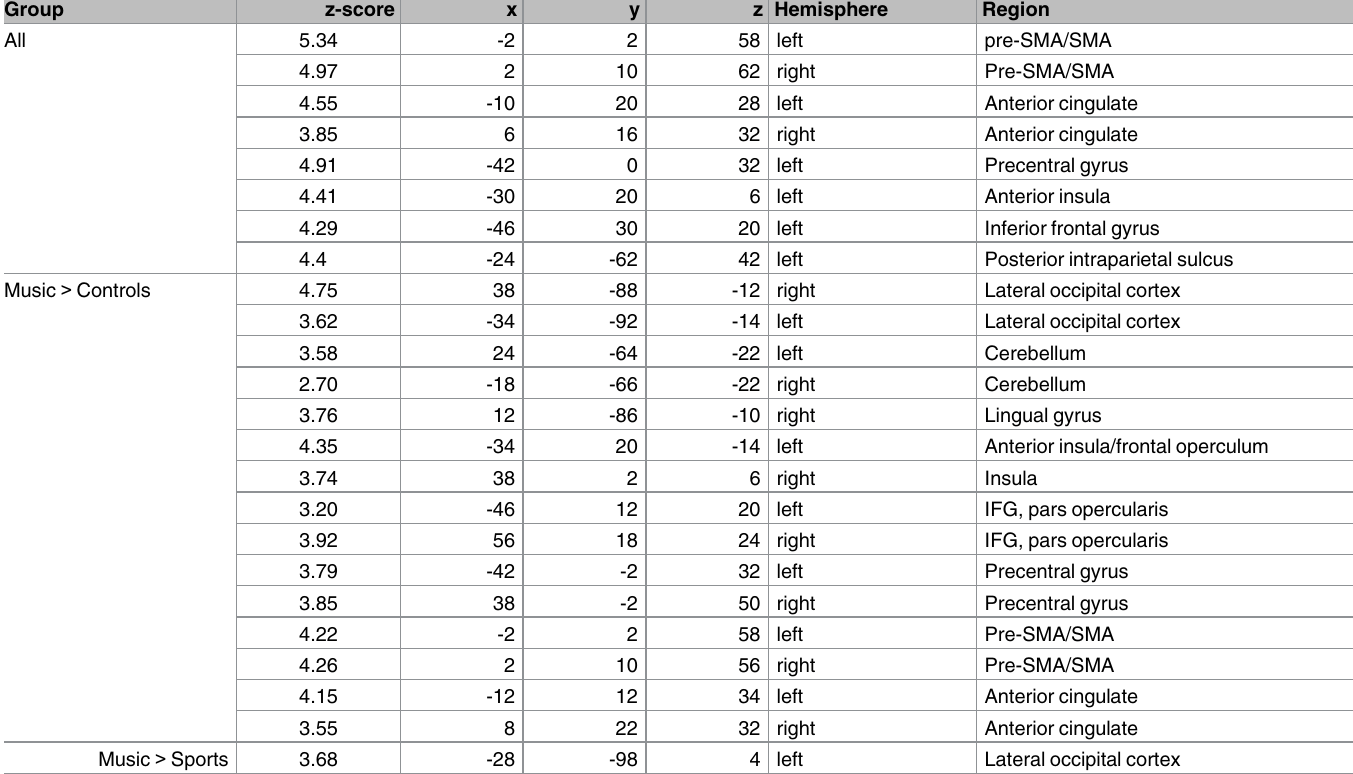
Music > Sports Lateral occipital cortex Coordinates represent the peak voxel of the cluster in MNI